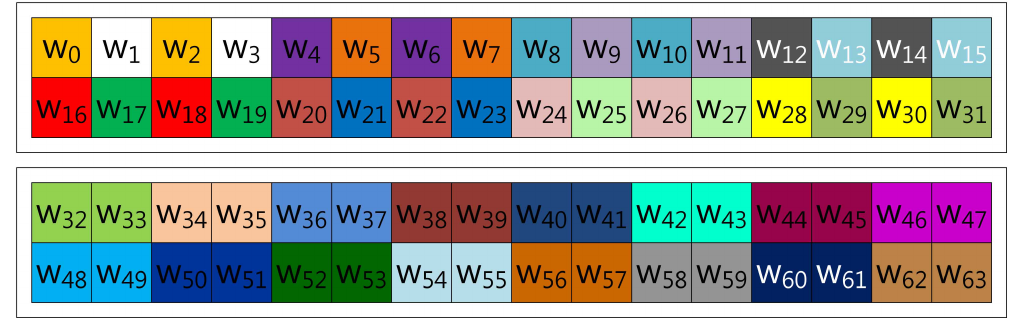
Figure 9. Look-up table structure of the (hybrid) proposed method in block form for 2NAF (speed-optimized model).